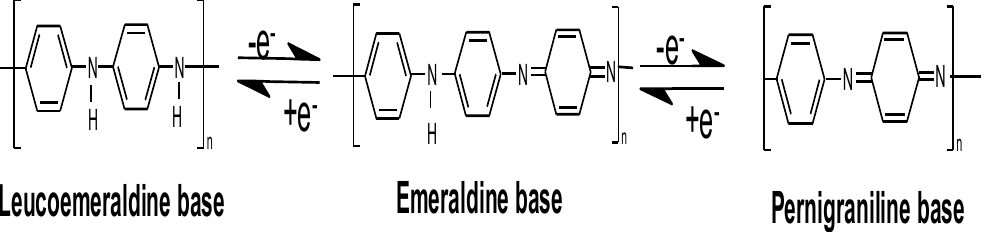
Figure 1. Oxidation states for PANi, ( middle ) emeraldine, ( left ) leucoemeraldine, and pernigraniline ( right ).